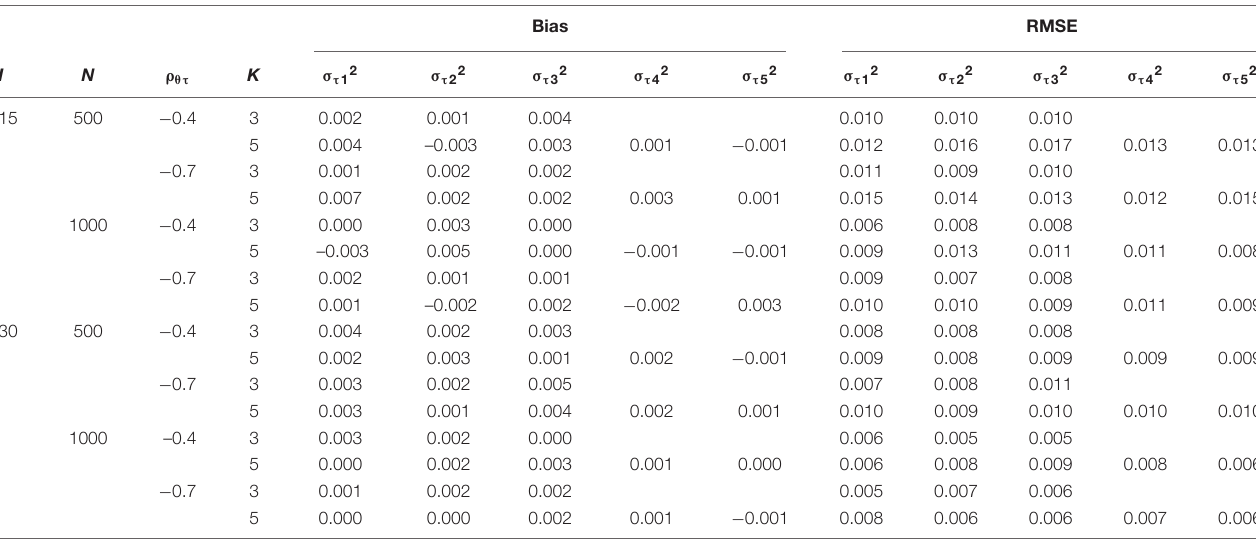
TABLE 9 | Recovery of the variance of speed factor in simulation study 1.